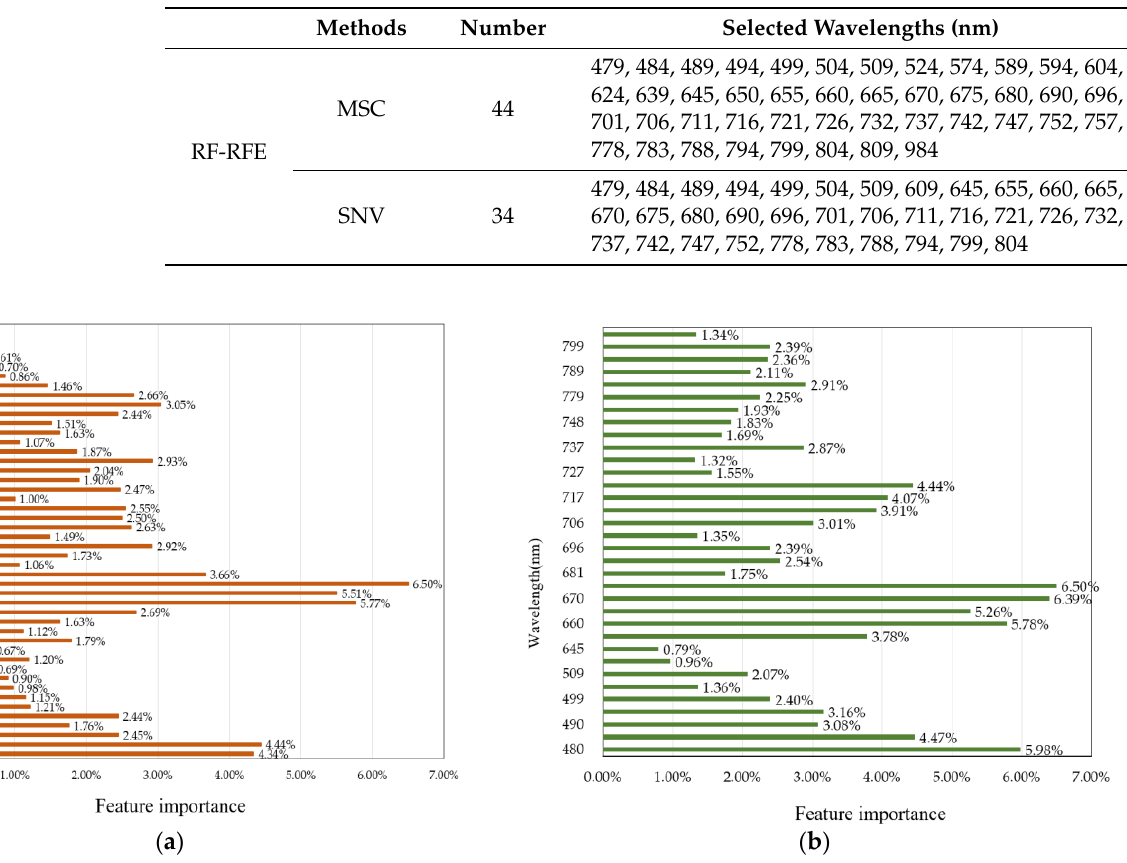
Table 2. The selected bands after two preprocessing methods combined with RF-RFE.